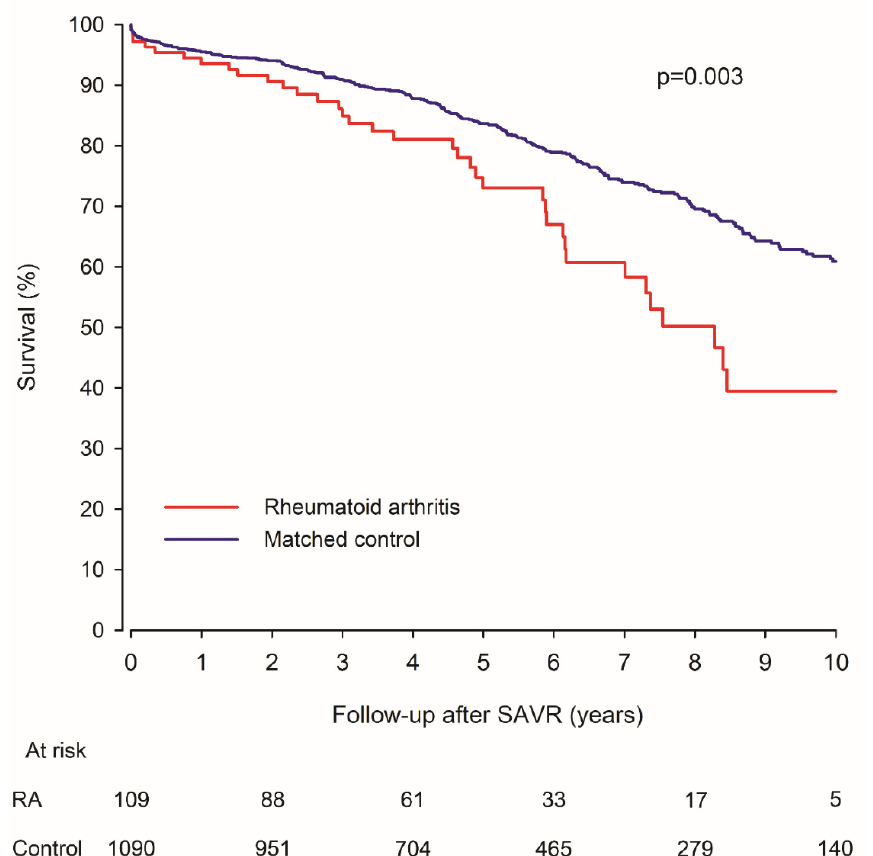
Figure 2. Survival of surgically treated aortic valve stenosis patients with rheumatoid arthritis and matched control patients. RA = Rheumatoid arthritis. SAVR = Surgical aortic valve replacement.